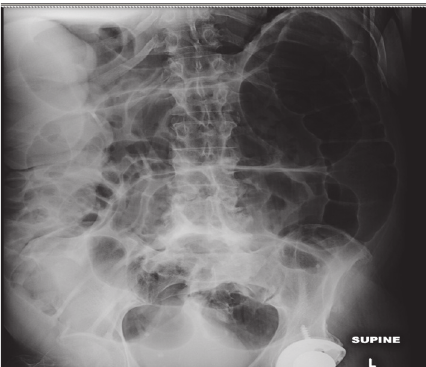
Figure 1: Abdominal X-ray showing severe colonic dilation due to pseudoobstruction.